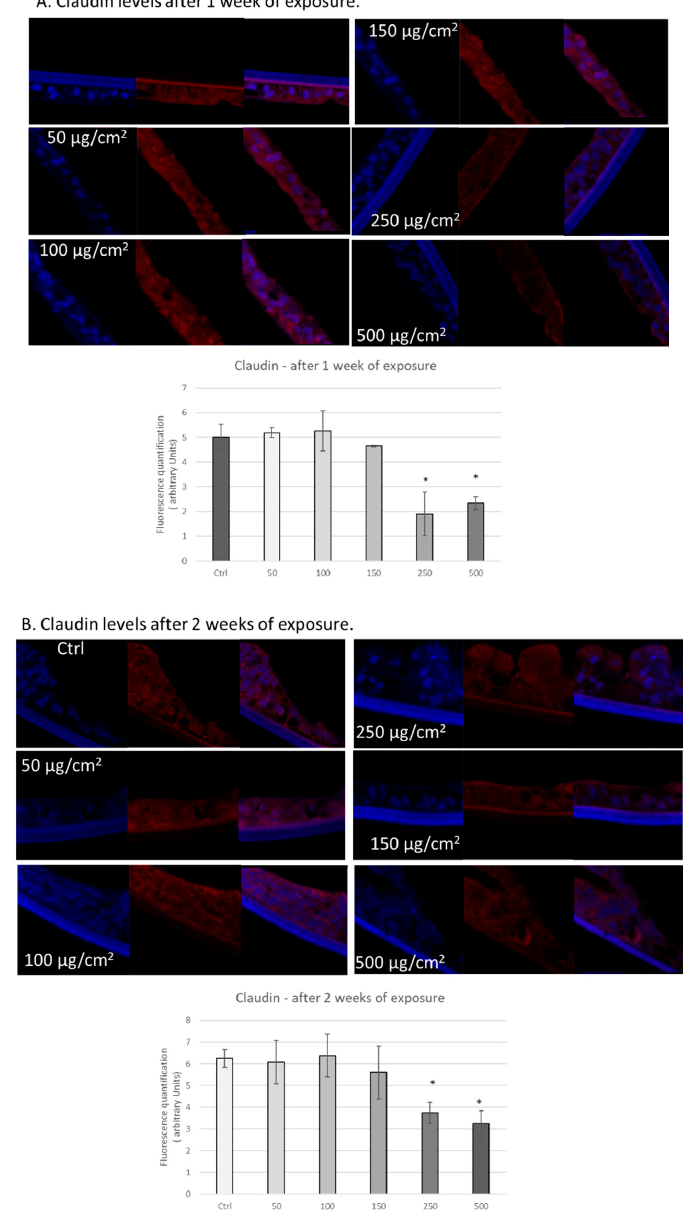
Figure 4. Exposure to particulate matter decreased levels of claudin after one week and two weeks of exposure. Representative immunofluorescence images of levels of claudin (red color) in EpiIntestinal tissues after one week ( A ) or two weeks ( B ) of exposure with the following doses of PM: 50, 100, 150, 250, and 500 µ g / cm 2 . Red staining represents claudin. Blue staining represents DAPI. Quantification of at least three independent images taken of stained tissues from two independent experiments is represented in graphs A and B. Data are expressed as arbitrary units (averages ± SEM of two experiments, * p <